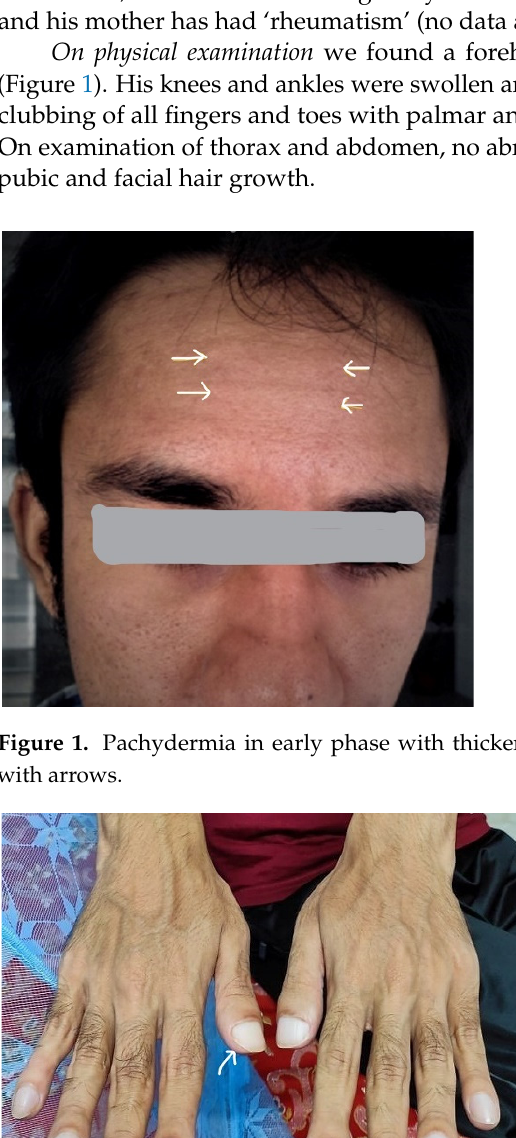
Figure 3. Clubbing of the toes, marked with arrows. Figure 4. X-ray of hand (2014) showing irregular periosteal hypertrophy with soft tissue swelling and new bone formations affecting metacarpal bones and phalanges. New bone formation and soft tissue swelling are marked with arrows.